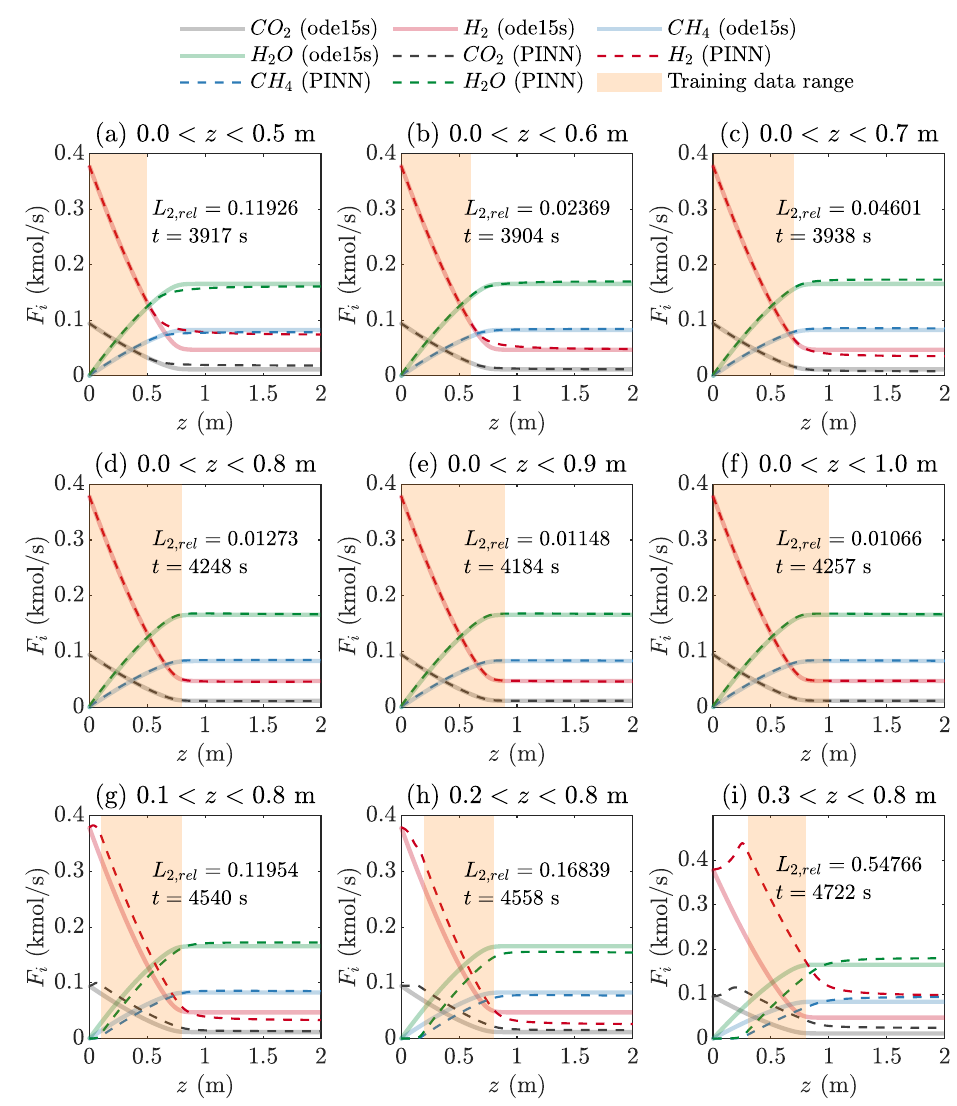
Figure 9. Performance of the forward PINN model using five hidden layers, 256 neurons, and the tanh activation function for 10,000 training data points in a limited range of the reactor length ( z ) and 1000 test data points in the full range of z : ( a ) 0 < z < 0.5 m, ( b ) 0 < z < 0.6 m, ( c ) 0 < z < 0.7